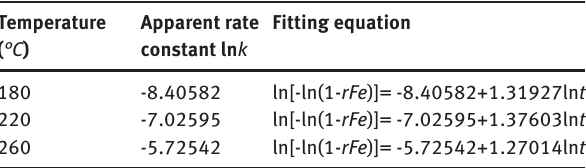
Table 4: Parameters of ln[-ln(1- r 160°C, 200°C and